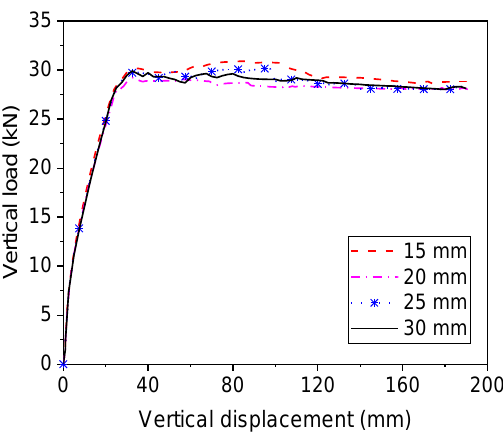
Figure 5. Effect of mesh size on load – displacement curve of frames.